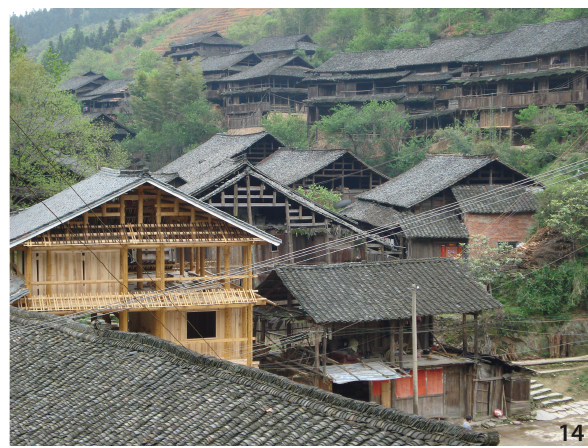
Figure 14 New residents built in traditional wood craft in Dong village in Chengyang, Guangxi (Source: the author).